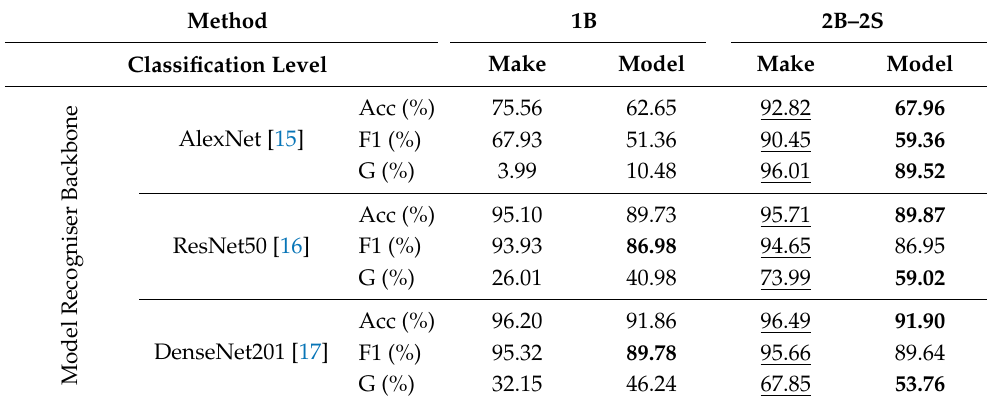
Table 10. VMMR results on DVMM.